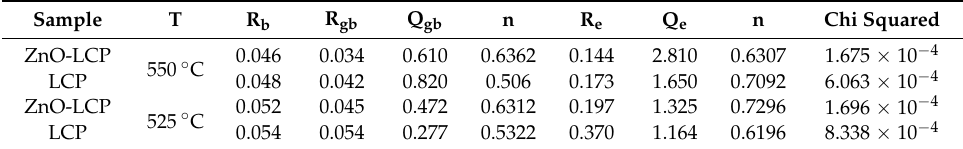
Table 2. The equivalent circuit analysis results of ZnO-LCP and LCP samples at 525 and 550 ◦ C, the R and Q have a unit of Ω cm 2 and S Sec n cm − 2 , respectively.